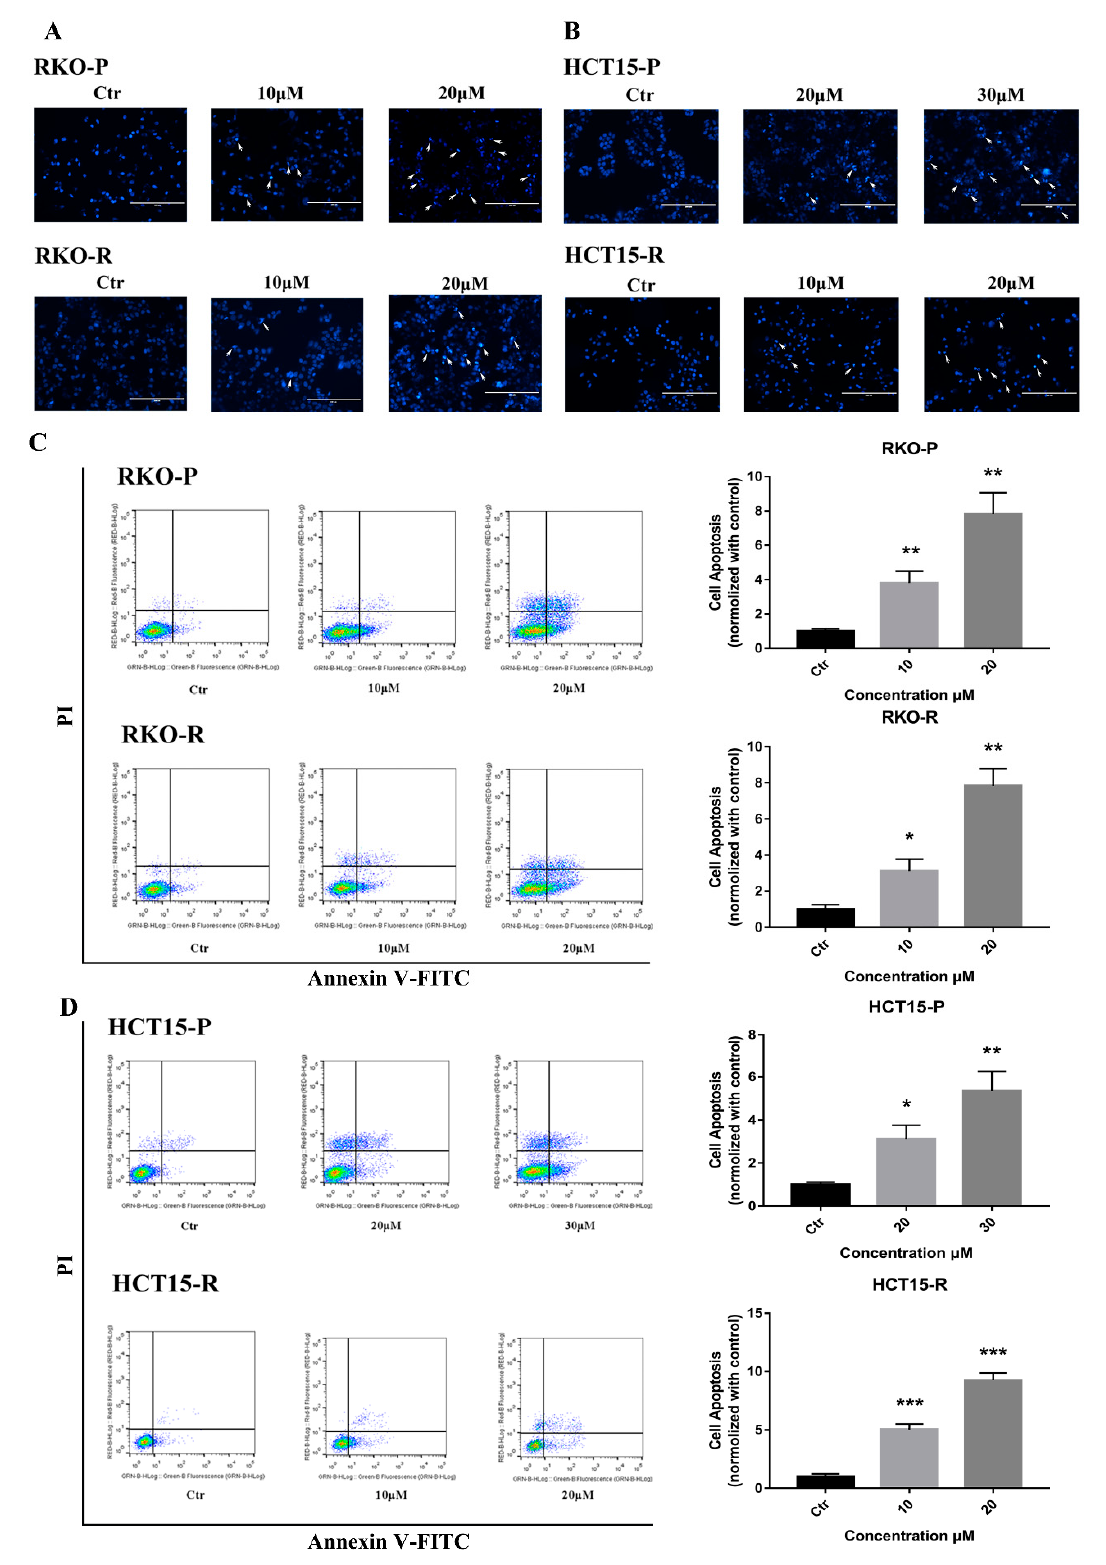
Figure 2. AGE induced apoptosis in 5-FU-sensitive/resistant CRC cell lines. ( A , B ): Cells were incubated with Hochst 33258 after 48 h of AGE treatment, then observed under a fluorescence microscope (200×). Arrow refers to condensed and bright chromatins. ( C , D ): Cells were treated with Annexin V-FITC/PI after 48 h of AGE incubation and detected by flow cytometry. The results of cell apoptosis normalized with control group are on the right bars. Results are expressed as mean ± SD ( n = 3). * p < 0.05, ** p < 0.01, *** p < 0.001, compared with Control (Ctr) group.